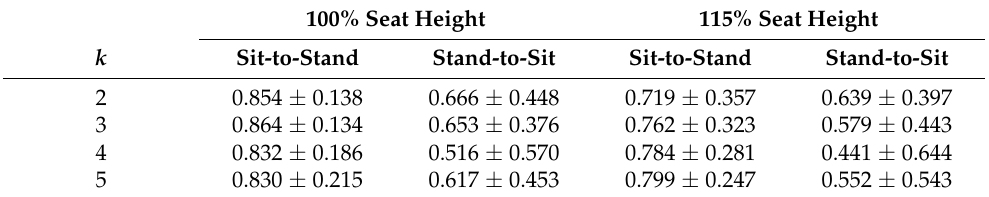
Figure 7. Example of full sit-to-stand action, showing points captured from individual markers. Only 6 stroke-affected participants were measured, each with significantly varying levels of impairment and movement patterns. Due to the small and diverse sample, averaging stroke participants data would have neglected the differences that arise from having suffered from impairments on different sides of their bodies. Thus, we made the decision to display and analyse each participant with stroke separately rather than focusing solely on average values. Table 2. Average R 2 with standard deviation values for different values of k when using height and weight as k − NN coordinates.